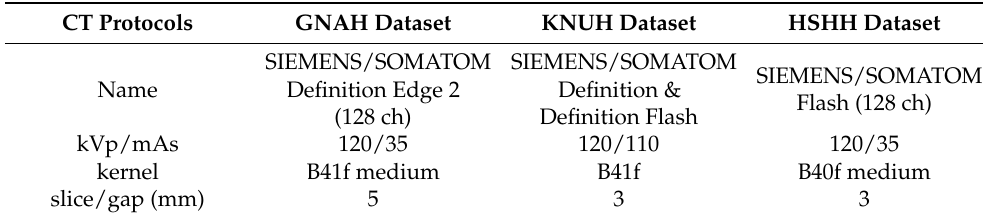
Table 1. Chest CT protocols at Gangneung Asan Hospital (GNAH), Kangwon National University Hospital (KNUH), and Hallym Sacred Heart Hospital (HSHH).